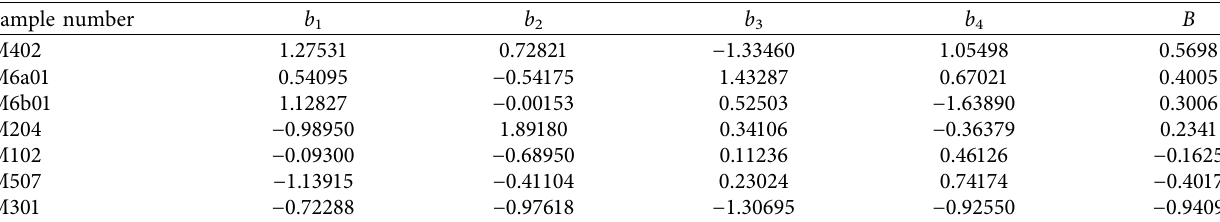
Table 4: Sample factors of incense burners in the ming